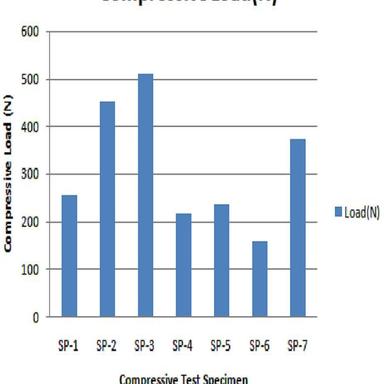
Compressive Load obtained by specimens.